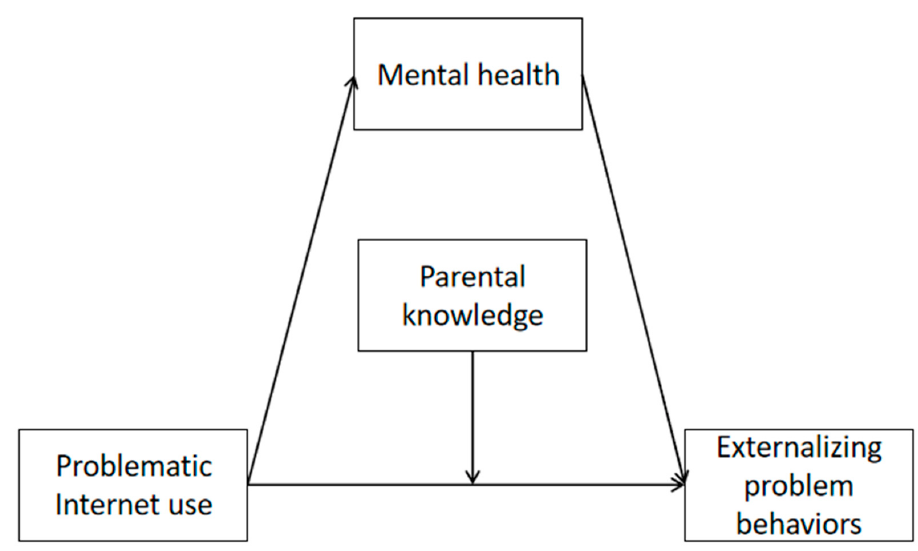
Figure 1. A hypothesized moderated mediation model.